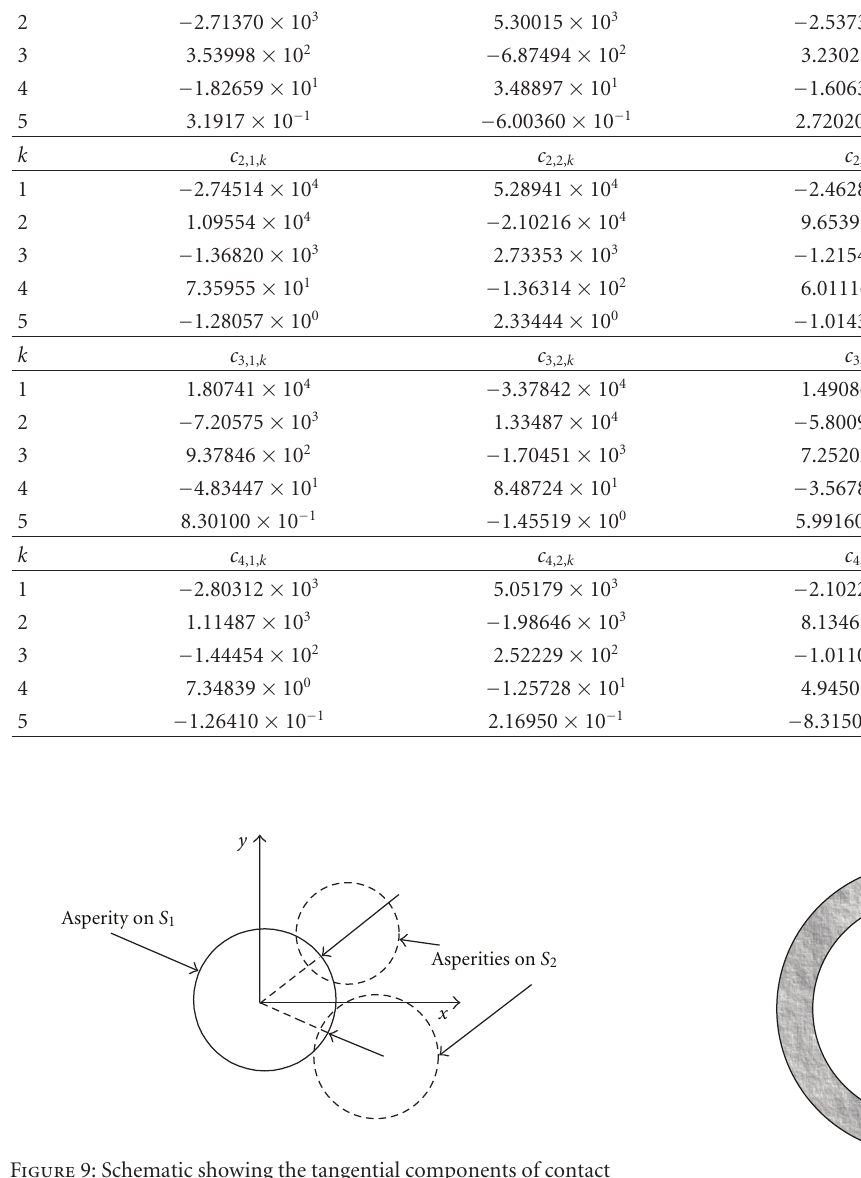
Figure 9: Schematic showing the tangential components of contact force exerted by two asperities of S 2 on an asperity on S 1 .